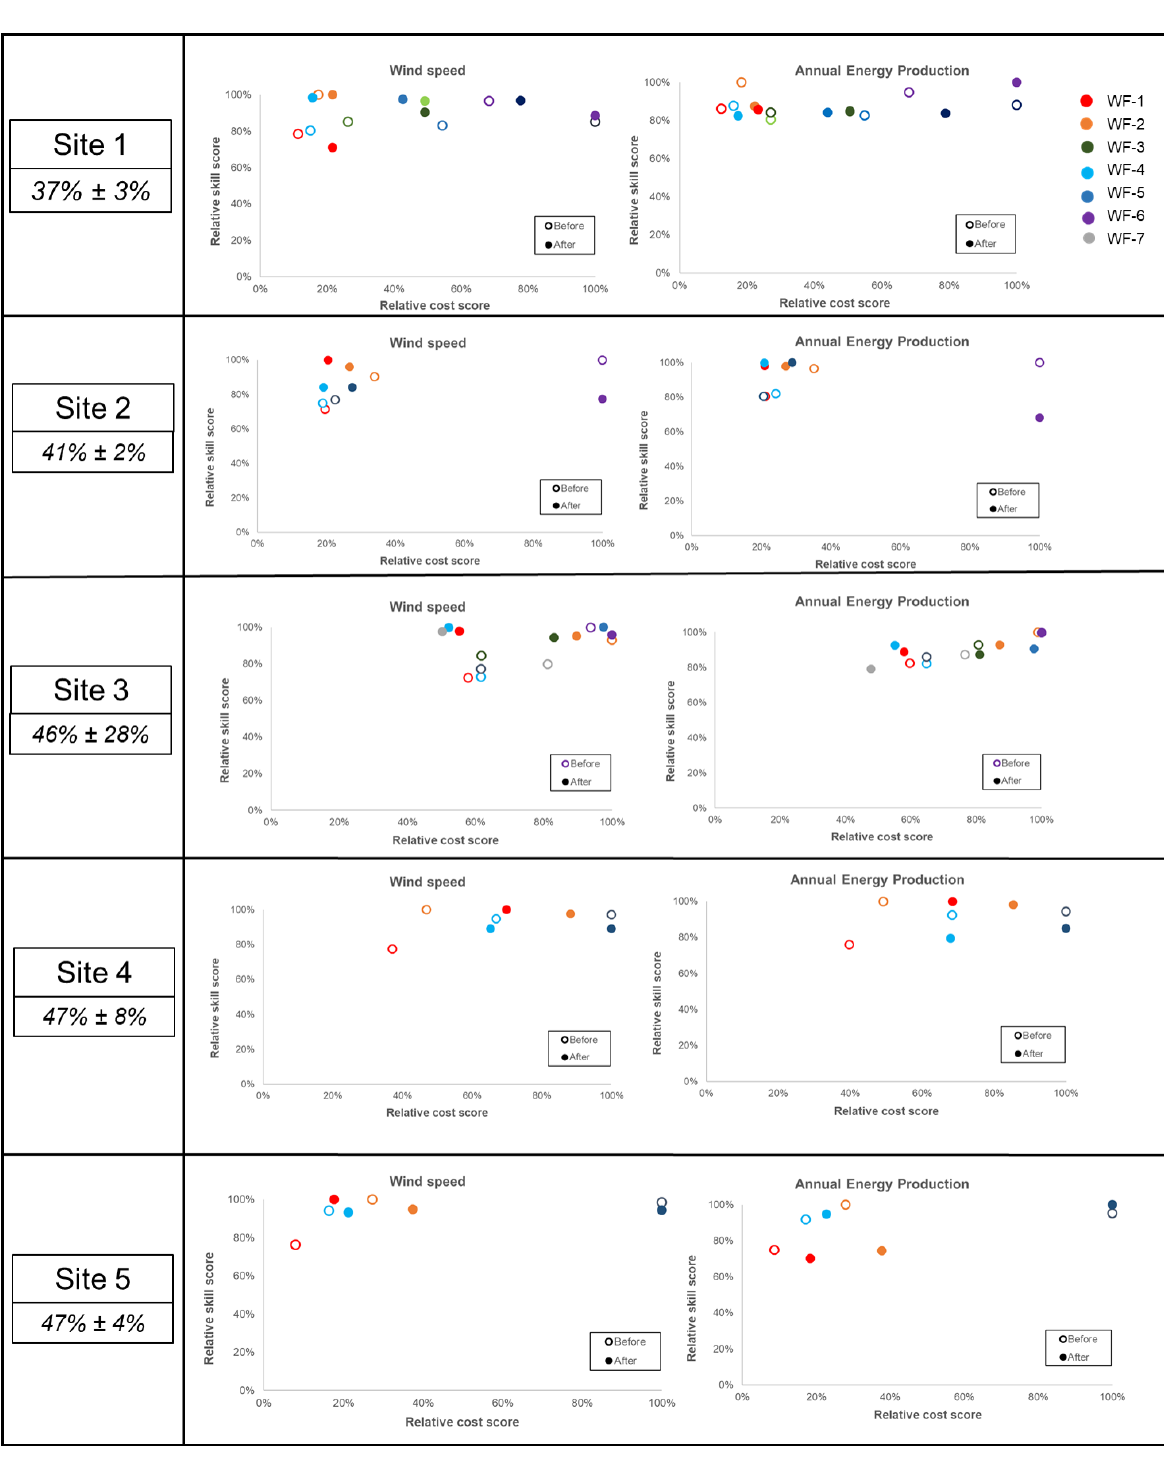
Figure 5. The skill score vs. cost score plots for all sites in this work. For wind speed at Site 1, the “before” results show that WF-1 (WindPro) was predicted to be the least accurate and least expensive model. WF-2 (WindSim) was expected to be slightly more expensive but much more accurate. WF-3 (CFX), WF-4, (Fluent RANS) and WF-5a and 5b (Fluent SBES) were expected to have an accuracy somewhere between the two, but at higher costs. WF-6 (PALM) was expected to be much more expensive but not more accurate. The weightings of the skill score parameters were adjusted by hand until a good match was